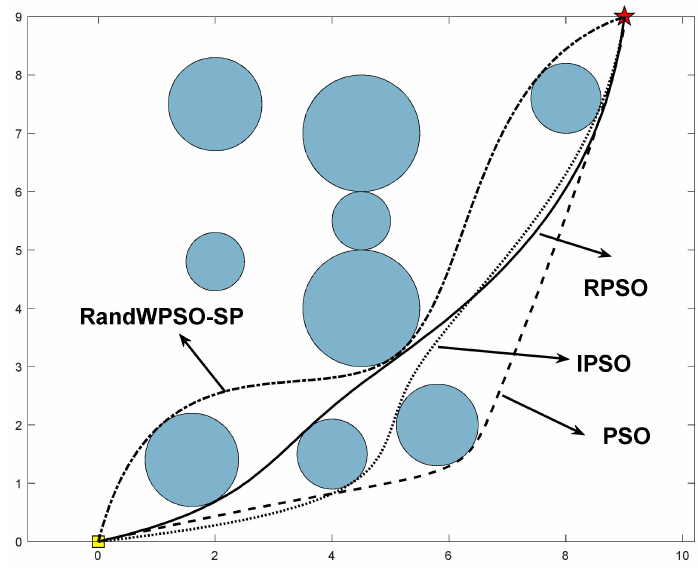
Figure 6. Comparison of path